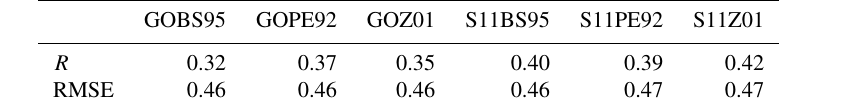
Table 6. Correlation coefficient ( R ) and root mean square error (RMSE) between the model and MODIS observation for AOD for six experiments over the 7d simulation period 1–7 May 2017.